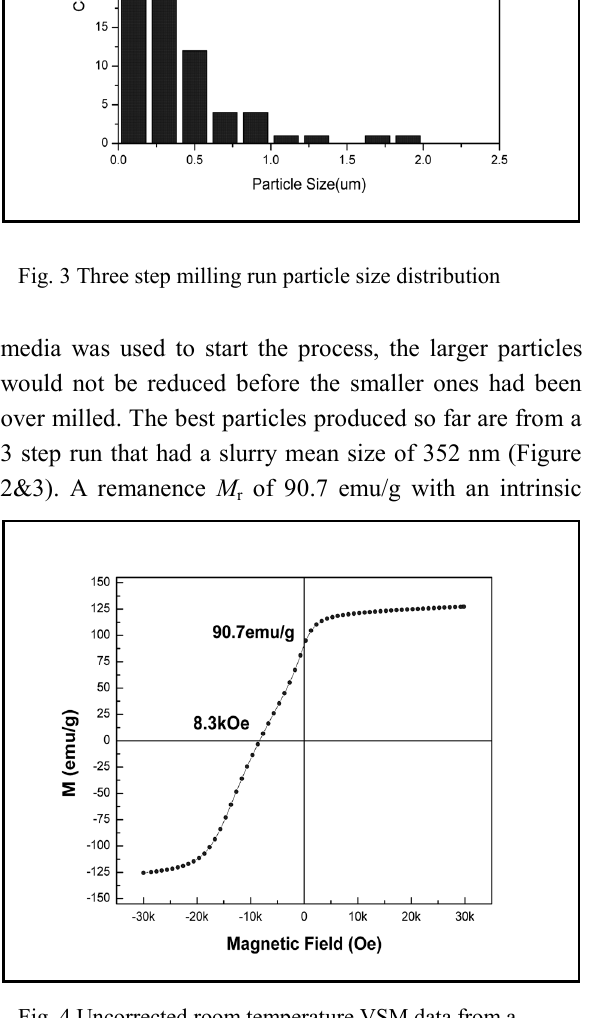
Fig. 4 Uncorrected room temperature VSM data from a three step run